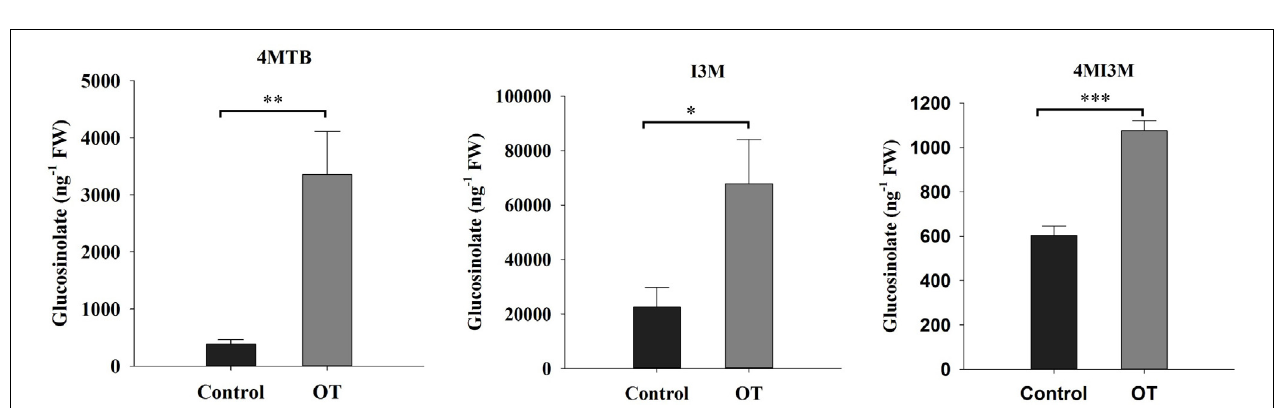
FIGURE 6 | The concentration of glucosinolates in β -ocimene-treated and control Chinese cabbages. OT, β -ocimene treated Chinese cabbage. Different letters over the bars designate a significant difference: ∗ P < 0.05, ∗∗ P < 0.01, ∗∗∗ P < 0.001.